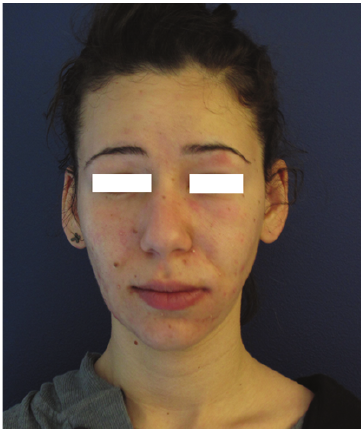
Figure 1: Erythema, edema, and pustules on the left side of the face.